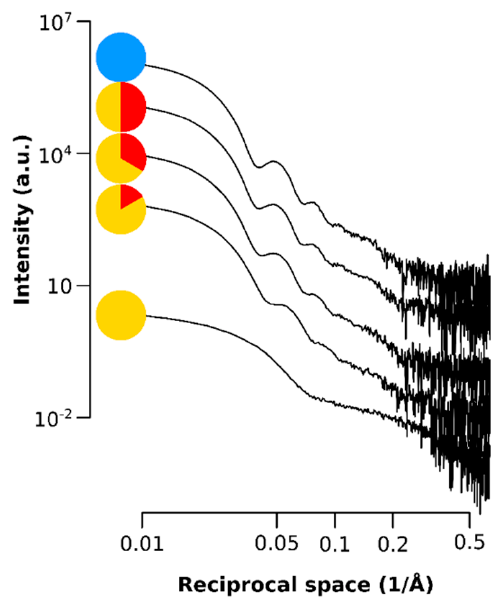
Figure A2. Small angle X-ray data showing the scattering intensity of the SPIONs for the q range of the SAXS at each time point.